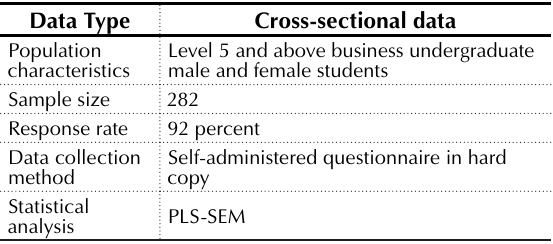
Table 1. Data characteristics